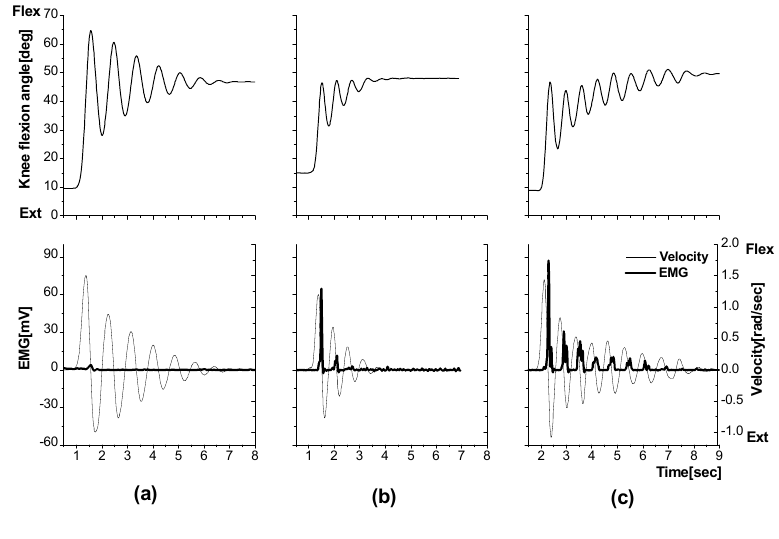
Fig. 4. Typical experimental data of three